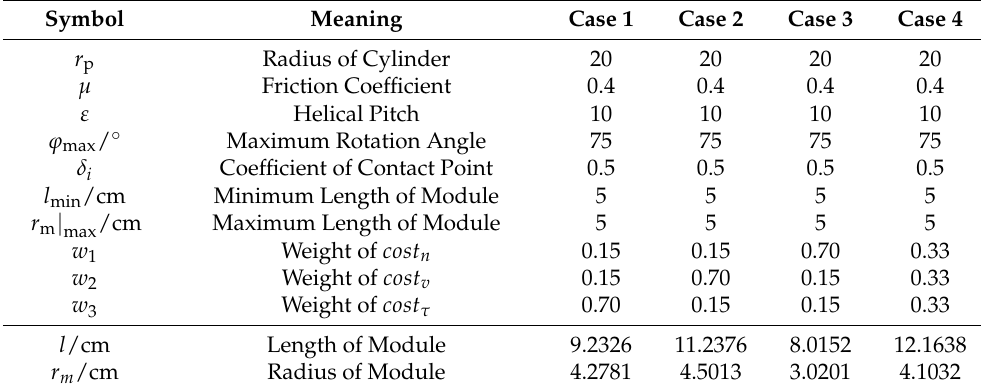
Table 3. The optimal design parameters of joint module when different